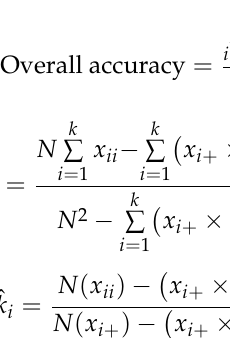
Figure 4. The variance explained by the VV, VH, and VV/VH components. The first three compo- nents, which explained greater than 70% of the variance, were